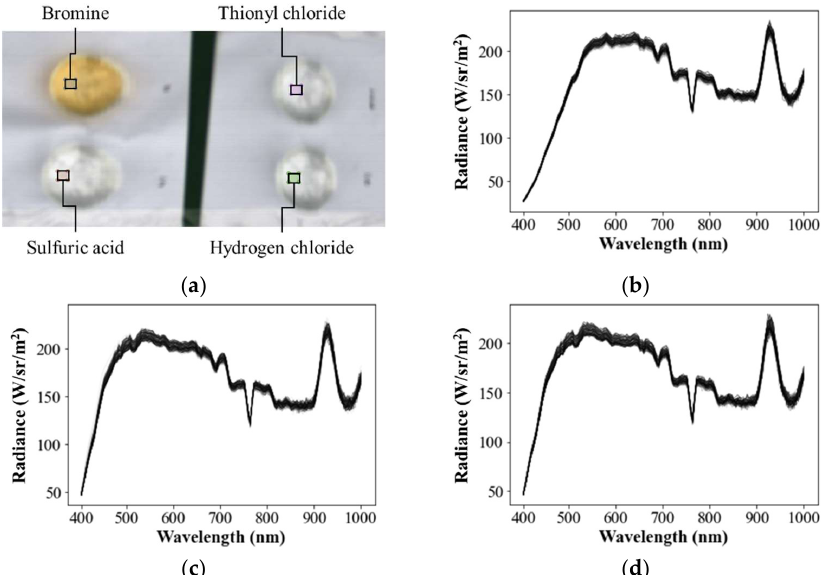
Figure 2. Example of spectral extraction and extracted spectral signatures. ( a ) Example of extraction of the spectral signature; ( b ) spectral signatures of river water and bromine mixture; ( c ) spectral signatures of river water and sulfuric acid mixture; ( d ) spectral signatures of river water and hydrogen chloride mixture.